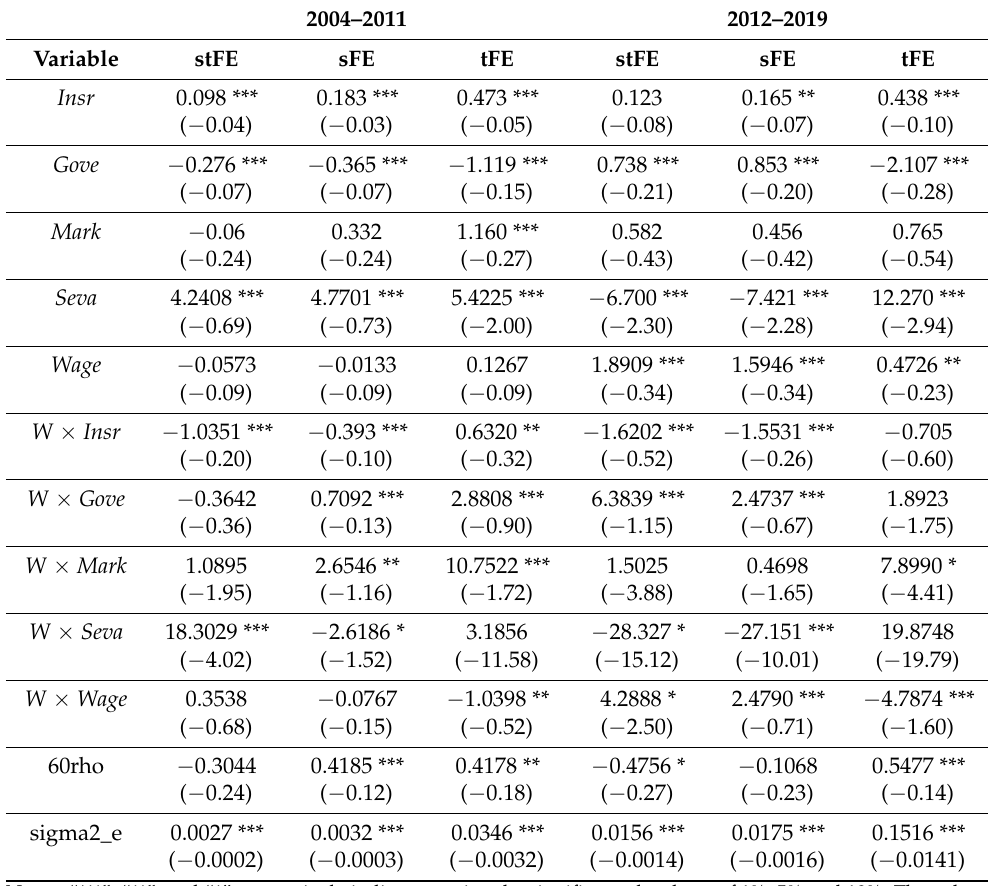
Table 5. Regression results of spatial models in different